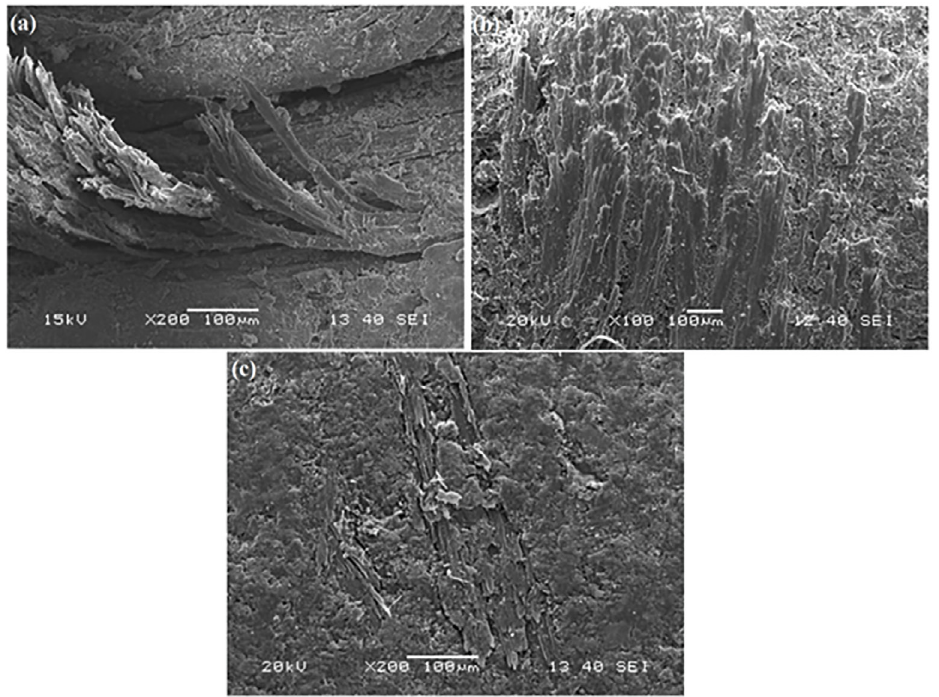
Figure 7. SEM images of (a) Untreated (b) Alkali treated and (c) Benzoyl chloride treated composite surfaces after three body abrasion at 30 wt.% of fiber loading subjected to Sliding distance of 50 m.